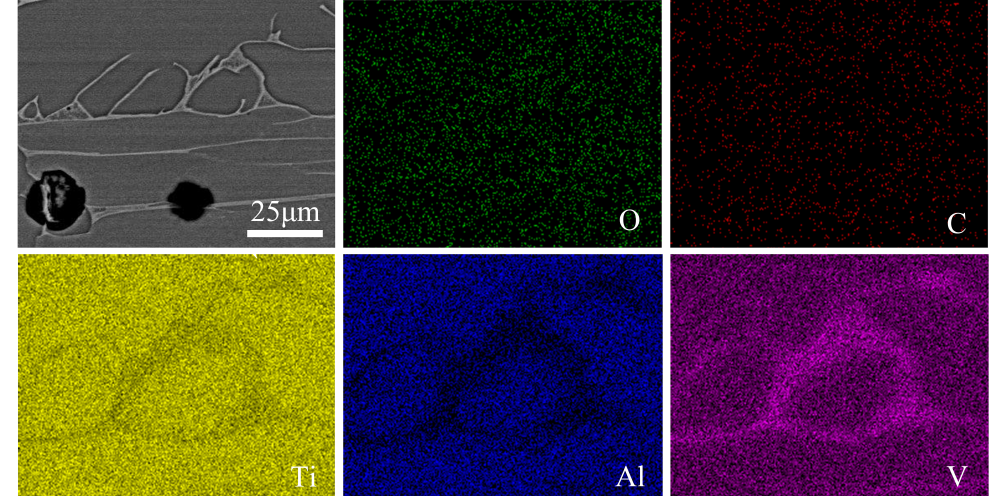
Figure 11. Scanning electron micrographs with EDS mapping elemental analysis of the mixed powder samples sintered at 1420 ◦